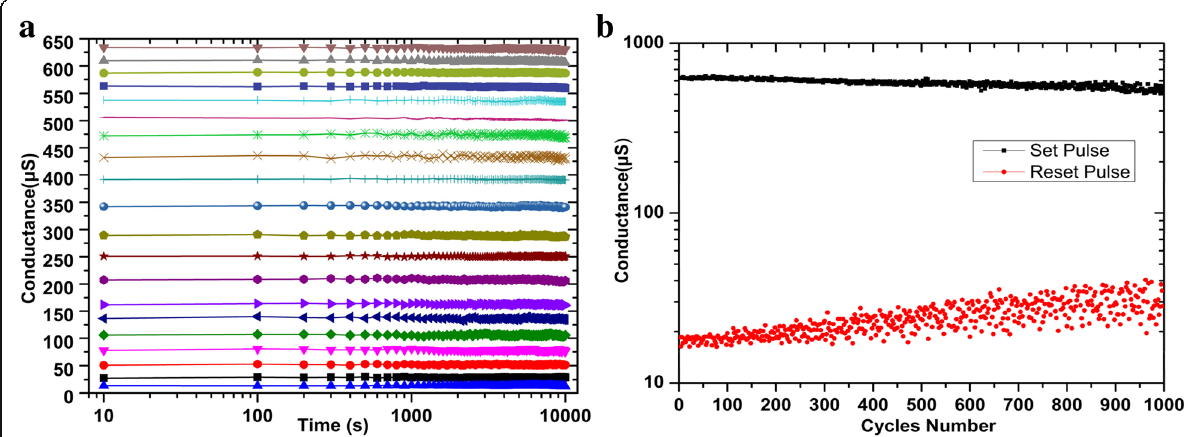
Fig. 8 The reliability tests of the devices. a Data retention characteristics after set/reset pulse operations. b Cycles endurance curves for